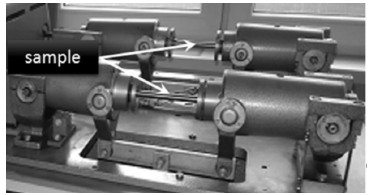
Figure 4. General view of the samples mounted on the fatigue machine [27].